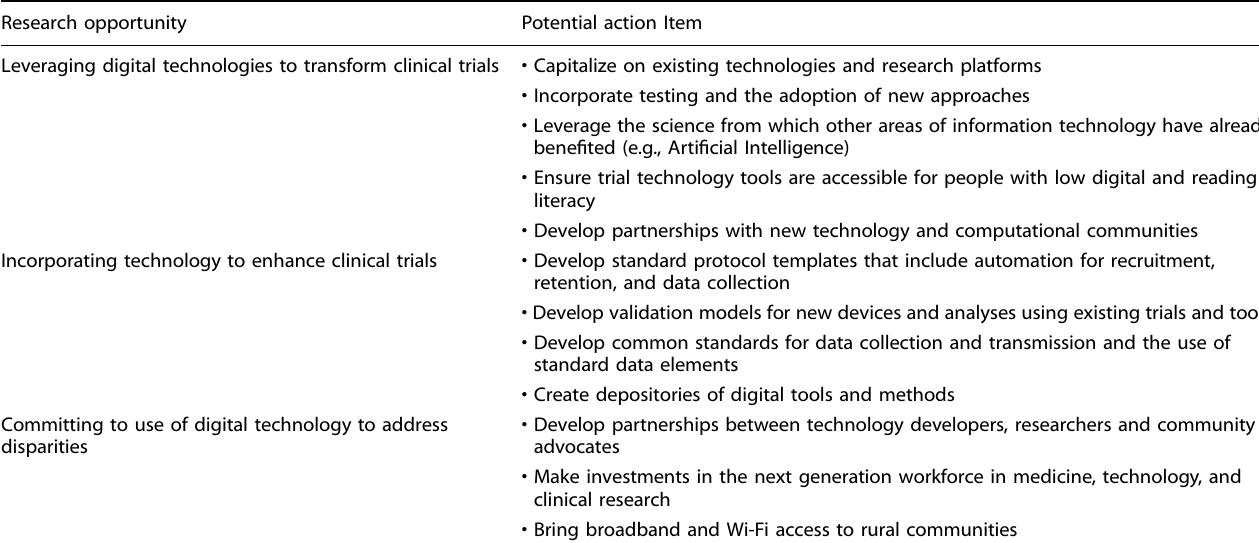
Table 2. Research opportunities and potential action Items from the NIH/NSF workshop on digital clinical trials. Research